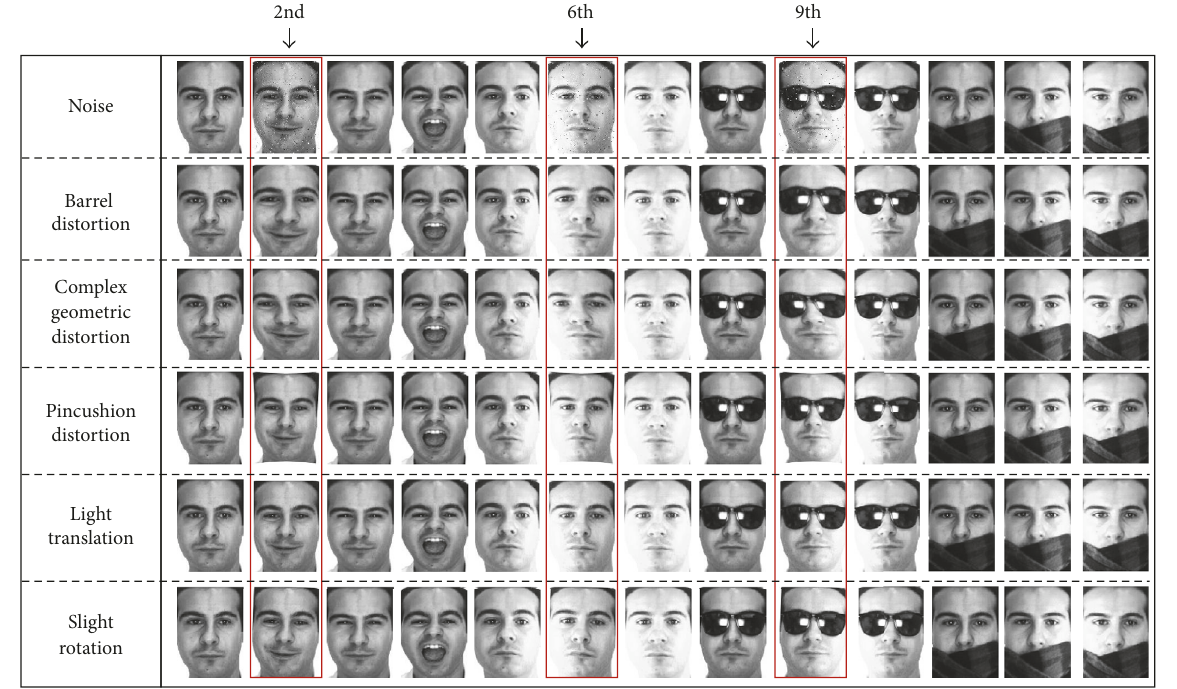
Figure 6: The details for the noise, geometric distortion, slight translation, and slight rotation AR face